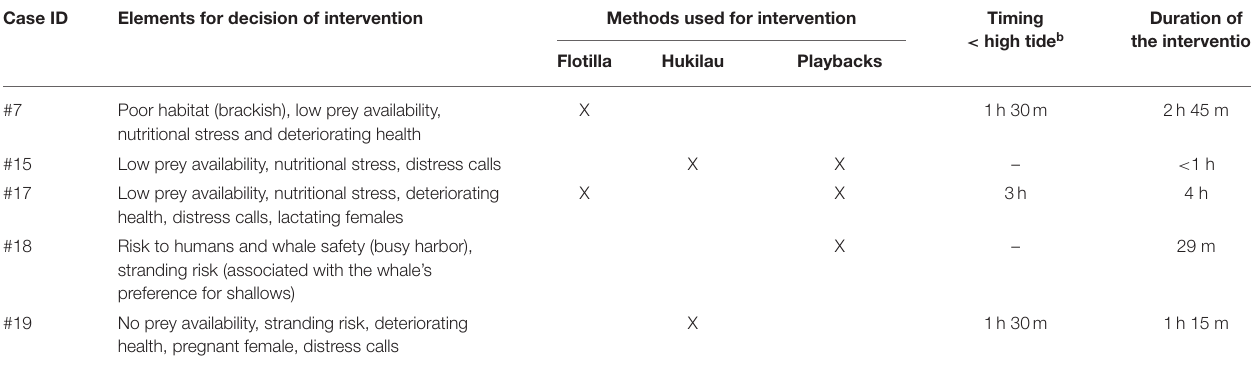
TABLE 4 | Summary of the key elements considered in the process of decision making and methods used to direct the killer whales back toward open waters for five a of the seven entrapments that led to human